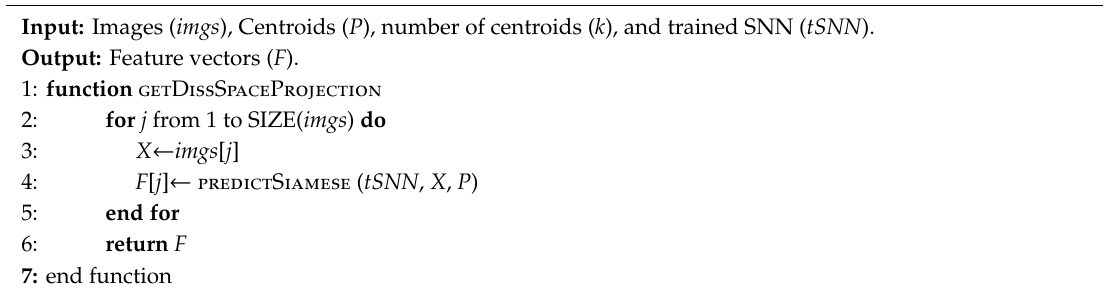
Algorithm 5. Projection in the Dissimilarity space